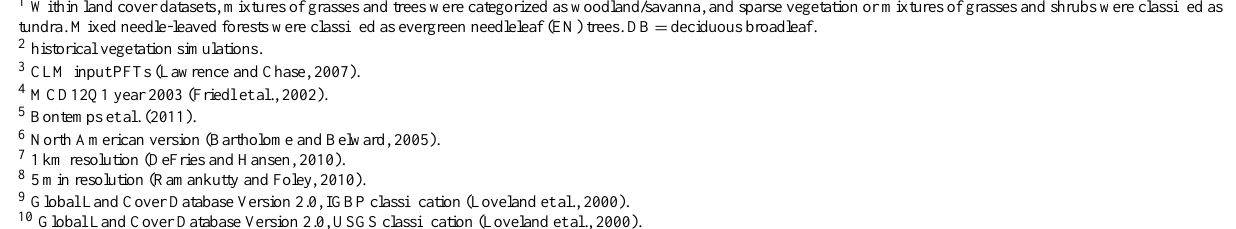
Table 1. Domain-wide vegetation type compositions (%) for historical vegetation simulations and global land cover datasets. Vegetation Type 1 BA × 1 2 CLM 3 MODIS GlobCover EN tree 49.4 DB tree Shrub Grass Not-vegetated